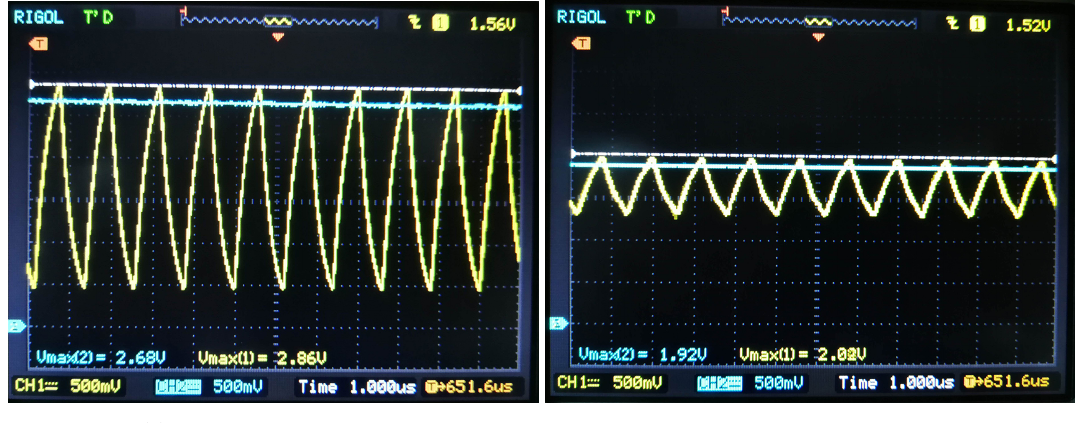
Figure 11. AC voltage at the capacitor sensor on CH1 and DC voltage output from the peak detector circuit on CH2. Both CH1 and CH2 are set to 500 mV/div and time base is 1 us/div. Measurement taken with a RIGOL DS1052E